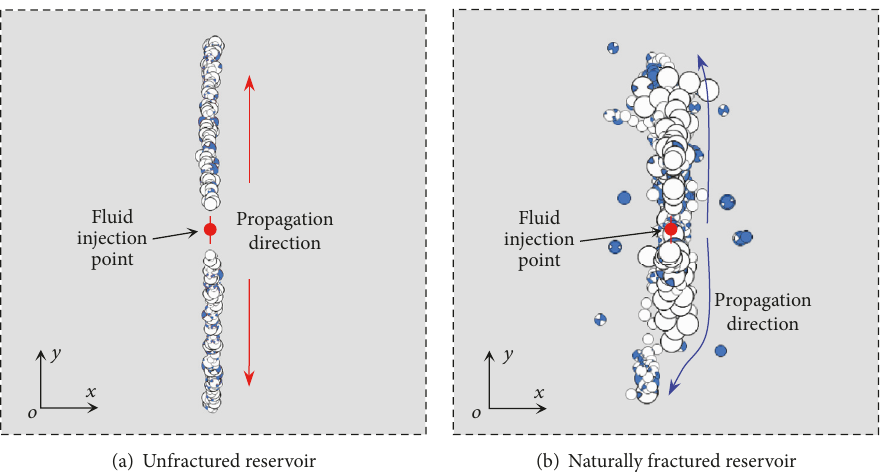
Figure 13: Focal spheres for distribution of final damaged events.